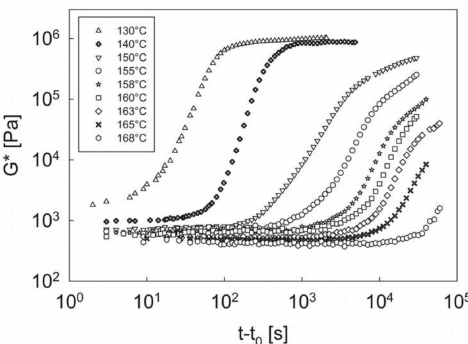
Figure 6. The complex modulus as a function of the reduced time t − t 0 (where t 0 is the time when the target temperature is first reached) during isothermal experiments at different annealing temperatures.